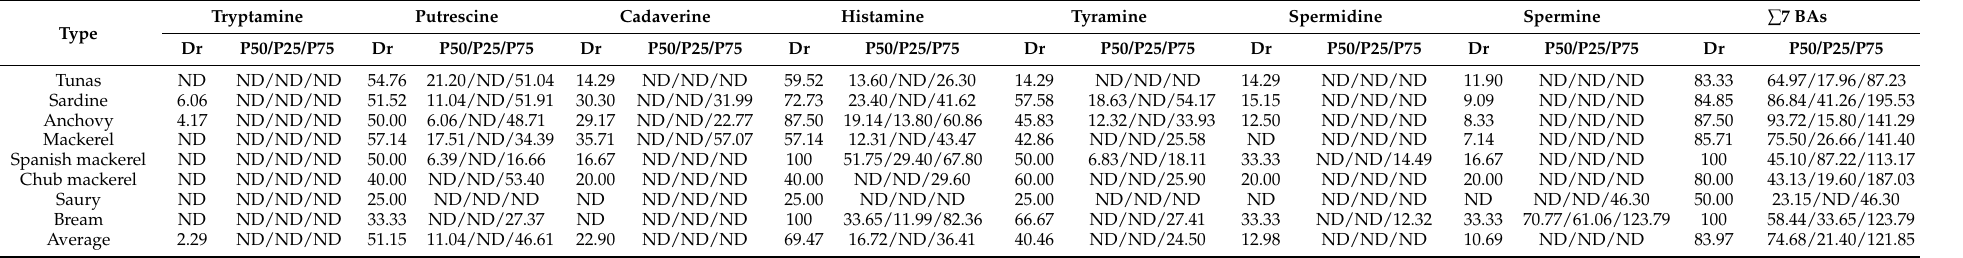
Table 3. Detection rate (Dr, %) and quartile of 7 BAs in eight categories of canned sea fish samples ( n =